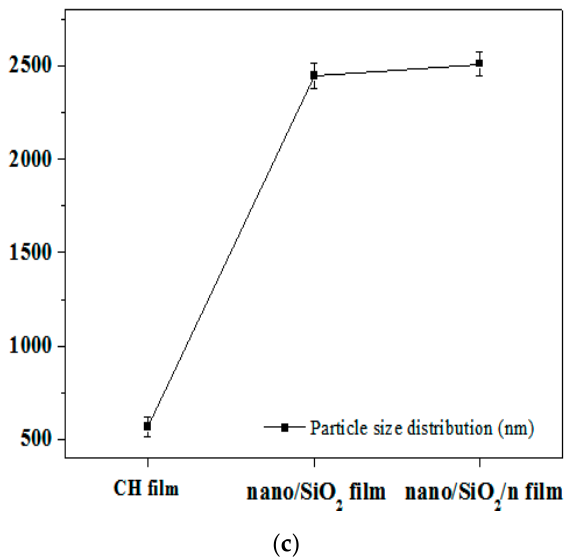
Figure 7. Performance characterizes of thin novel films; ( a )turbidity and polydispersity index; ( b ) zeta potential and contact angle; ( c ) partial size distribution.